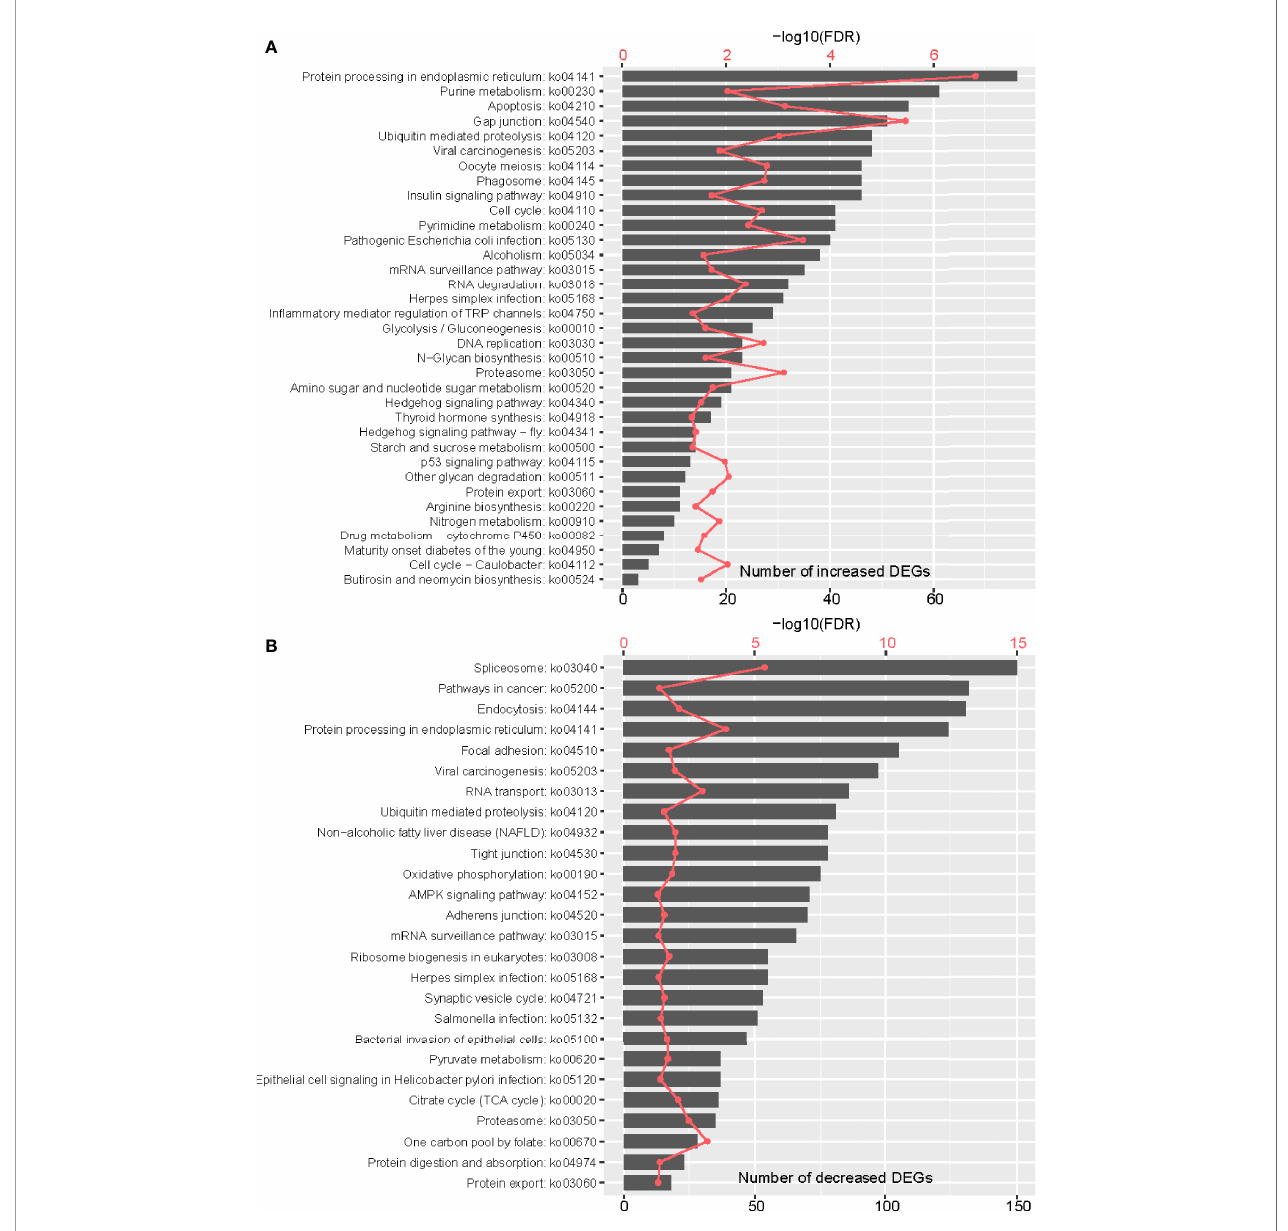
FIGURE 3 | Functional analyses of DEGs between adult stage and metacercariae stage. (A) showed the enrichment of DEGs in GO function, and (B) showed the enrichment of DEGs in KEGG function. Only results with FDR < 0.05 are